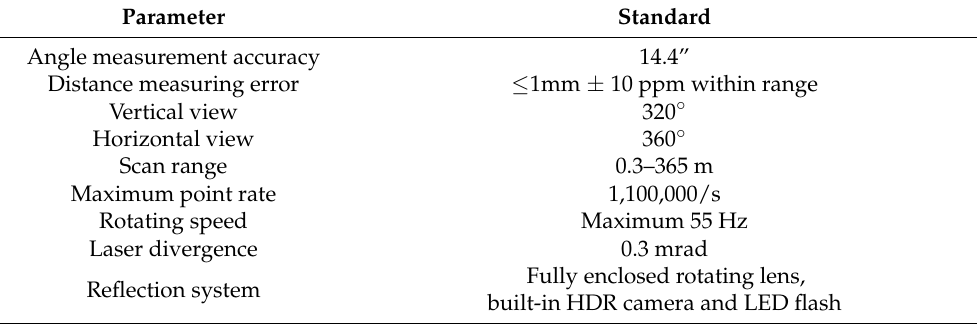
Figure 5. Z + F 5016 scanner. Table 1. Main technical parameters of the s Z + F 5016canner.